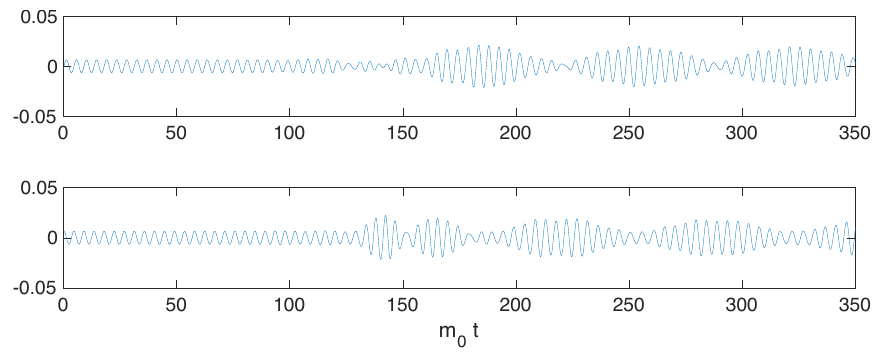
Figure 1 . An example of f 1 ( t; r = (cid:26) ) for j = 4 1 oscillon. The top (cid:12)gure is the real part of f 1 and the lower is the imaginary part.